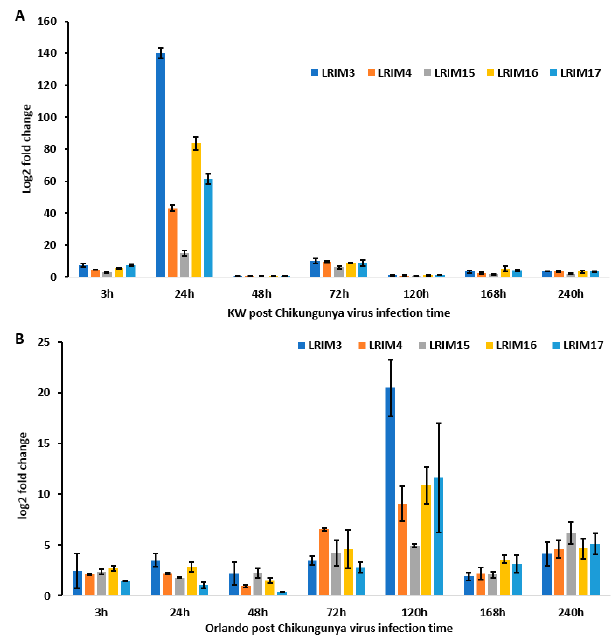
Figure 5. AaeLRIM3, AaeLRIM4, AaeLRIM15, AaeLRIM16, and AaeLRIM17 relative expression level